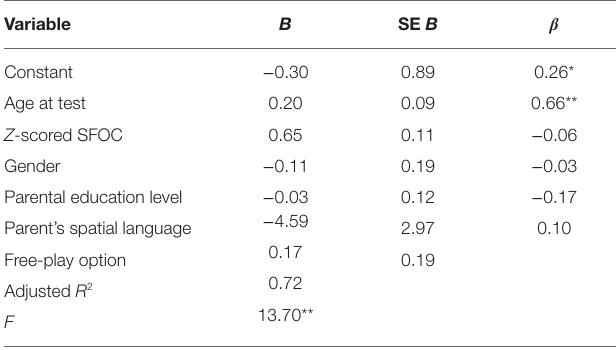
TABLE 4 | Summary of linear regression analysis for six variables (child’s age at test, gender, z -scored SFOC, parental education level, parent’s use of spatial language, and free-play option) predicting Spontaneous Focus on Space. B SE B